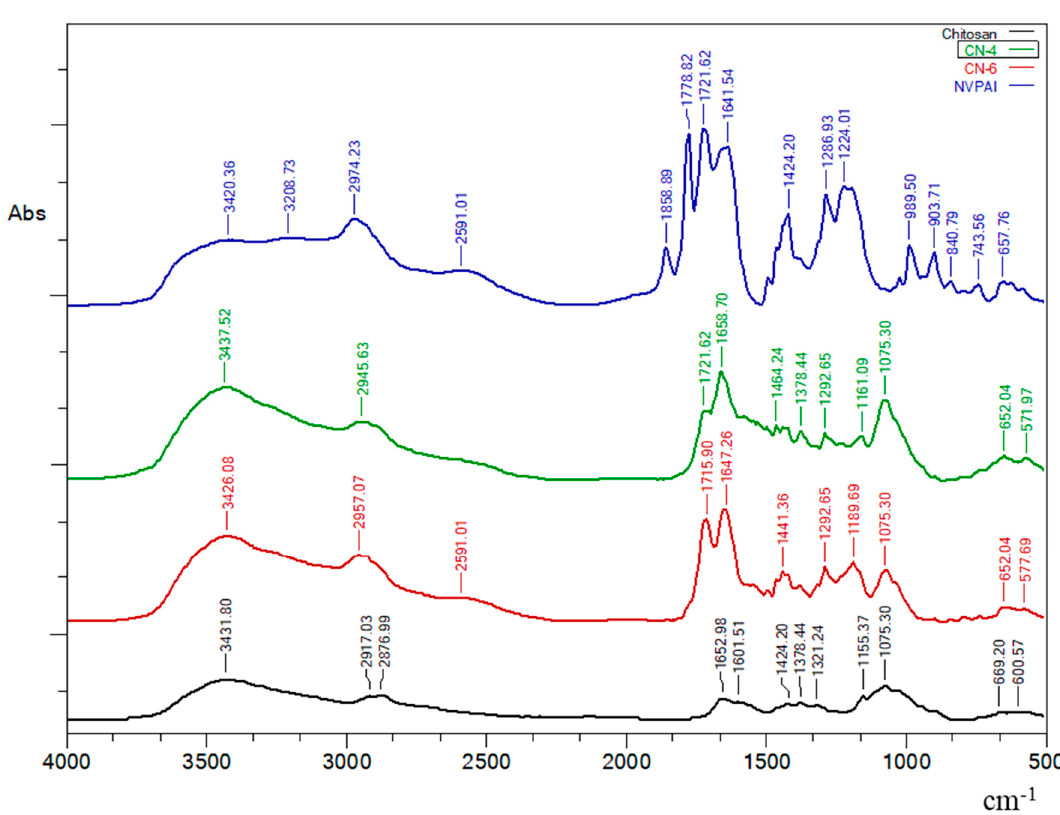
Figure 1. FTIR spectra of CS, NVPAI, CN-4 and CN-6 samples.